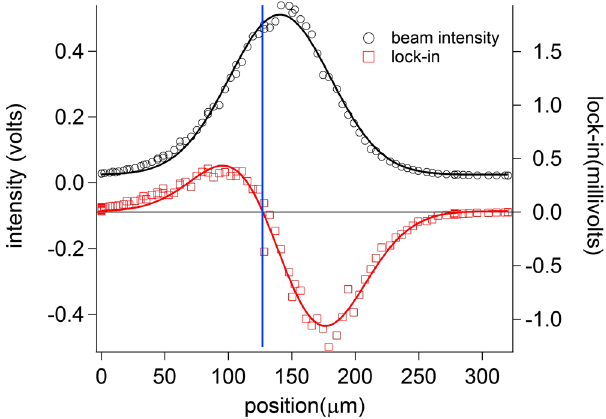
where V is the lock-in signal. When the oscillation L amplitude is small with respect to the beam size, V 0 , ψ σ can be estimated by fitting the beam intensity in 0 , and Fig. 5 using Eq. (1) with ψ 0 set to zero. The oscillation amplitude ψ 0 is then estimated by fitting lock-in signal to Eq. (2). Extremum seeking feedback aims to configure the horizontal steering such the V is zero. When b is zero, L Eq. (2) predicts a purely antisymmetric lock-in signal, and the V zero crossing corresponds to maximum intensity. L When b is nonzero and ψ 0 zero, the lock-in traces out the beam profile. When both b and ψ 0 are nonzero the lock-in signal is neither antisymmetric nor symmetric, but rather asymmetric, and the V zero crossing no longer coincides L with maximum intensity. Adding an offset between the lock-in and integrator compensates this effect, vertically shifting the lock-in curve in Fig. 5 until the zero points coincide with the position maximum. The drawback of the offset is that the piezo drive voltage swings instead of pausing when the beam is removed from the detector downstream from the